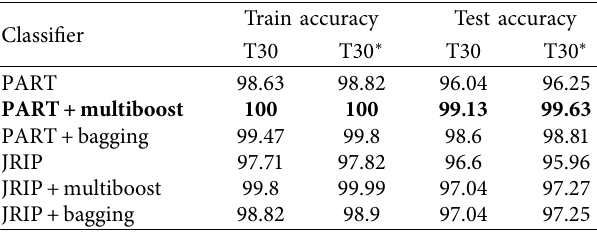
Table 11: Classifier performance in terms of train accuracy and test accuracy values for dataset A for Exp. 3.